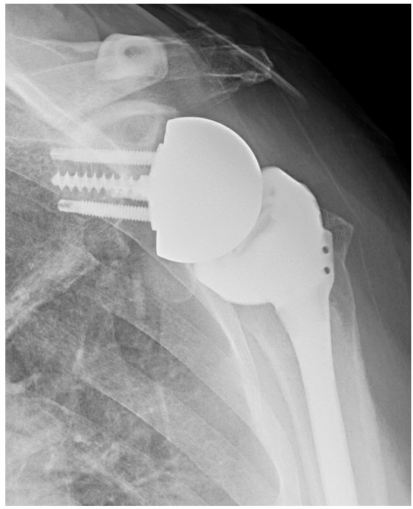
Figure 5. Lateralized RSA. AP X-ray of lateralized glenoid